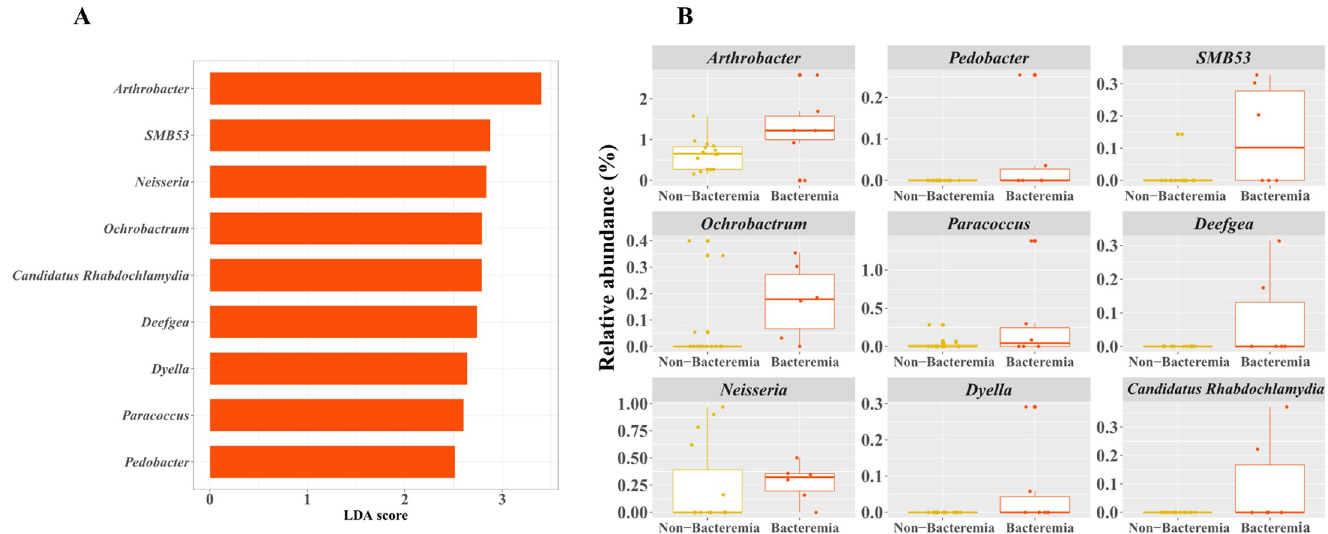
Fig 3. Differential abundance of taxa between bacteremic and non-bacteremic groups. (A) Taxa identified by linear effect size with linear discriminant analysis (LDA) values of 2.5. Taxa enriched in different groups are displayed by color indicated in the key (red indicates taxa abundant in bacteremia) (B). Relative abundance of the nine discriminative genera selected from the LDA